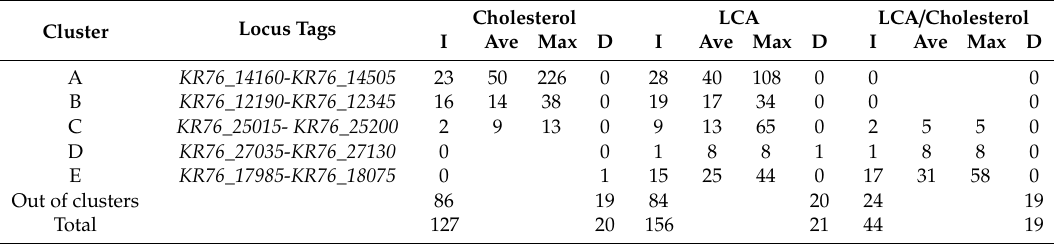
Table 2. Di ff erentially expressed genes in gene